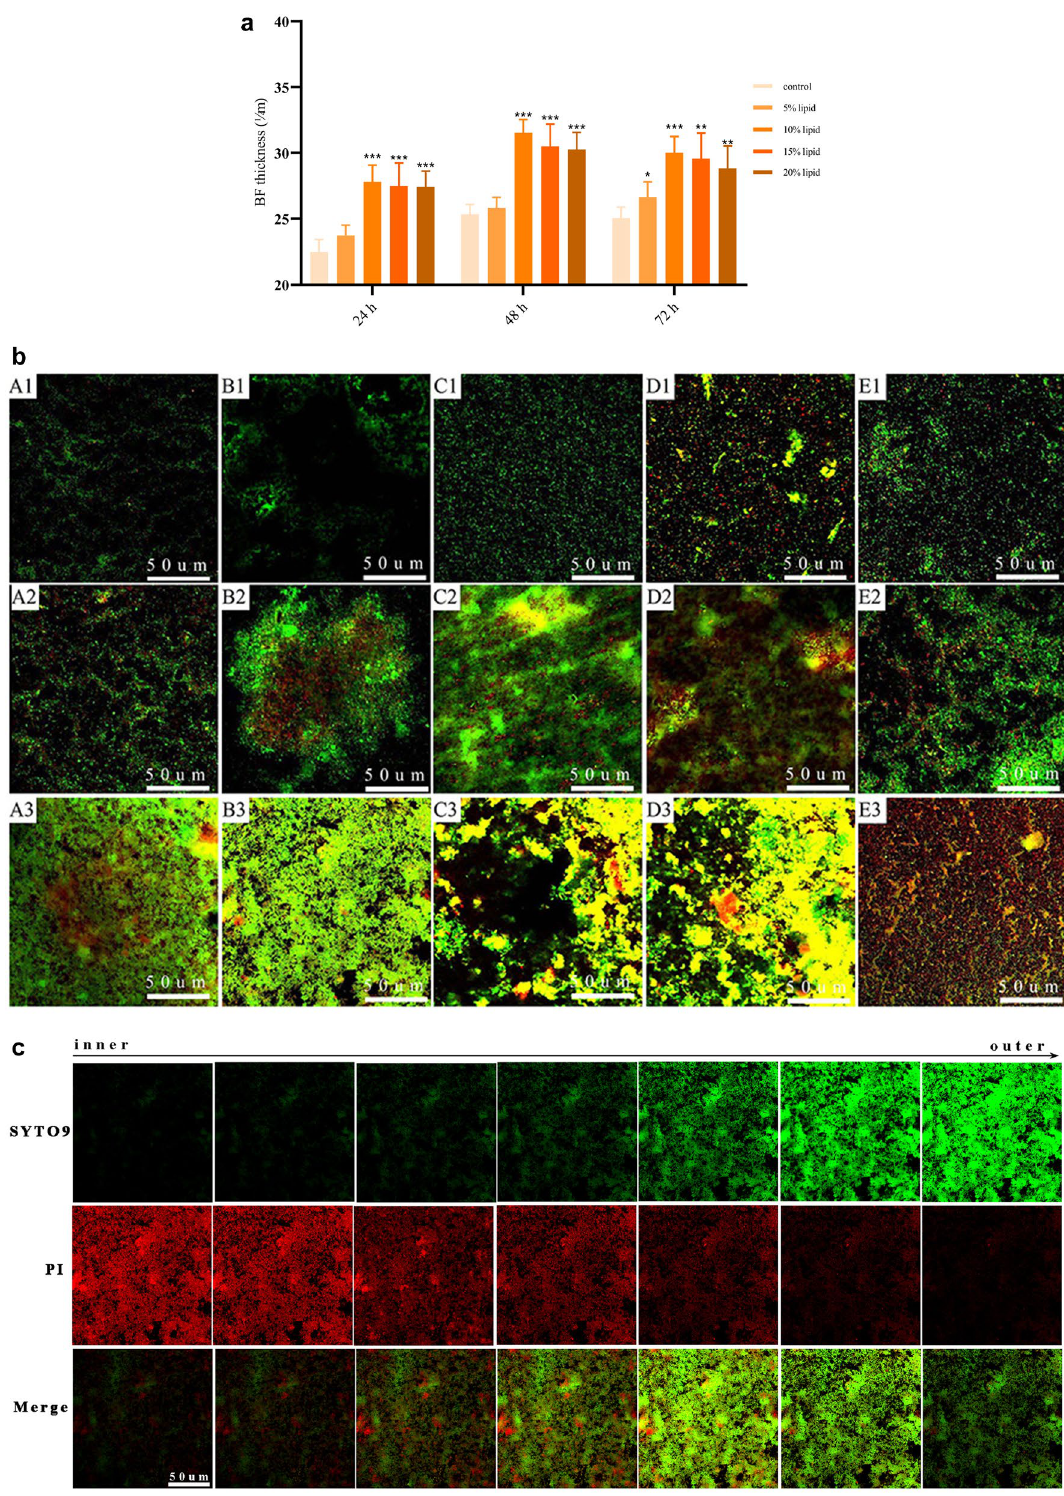
Figure 3. Thickness of mixed-species BFs at 24, 48, and 72 h. Compared with the control group at the same time, * P < 0.05, ** P < 0.01, *** P < 0.001 ( a ). Observation of mixed-species BFs by CLSM at 24, 48, and 72 h ( b ). Observation of the live/dead microbes of mixed-species BFs by CLSM ( c ). The images were obtained at × 200 magnification. ( A1 ) Control group (24 h); ( B1 ) 5% lipid emulsion group (24 h); ( C1 ) 10% lipid emulsion group (24 h); ( D1 ) 15% lipid emulsion group (24 h); ( E1 ) 20% lipid emulsion group (24 h); ( A2 ) control group (48 h); ( B2 ) 5% lipid emulsion group (48 h); ( C2 ) 10% lipid emulsion group (48 h); ( D2 ) 15% lipid emulsion group (48 h); ( E2 ) 20% lipid emulsion group (48 h); ( A3 ) control group (72 h); ( B3 ) 5% lipid emulsion group (72 h); ( C3 ) 10% lipid emulsion group (72 h); ( D3 ) 15% lipid emulsion group (72 h); ( E3 ) 20% lipid emulsion group (72